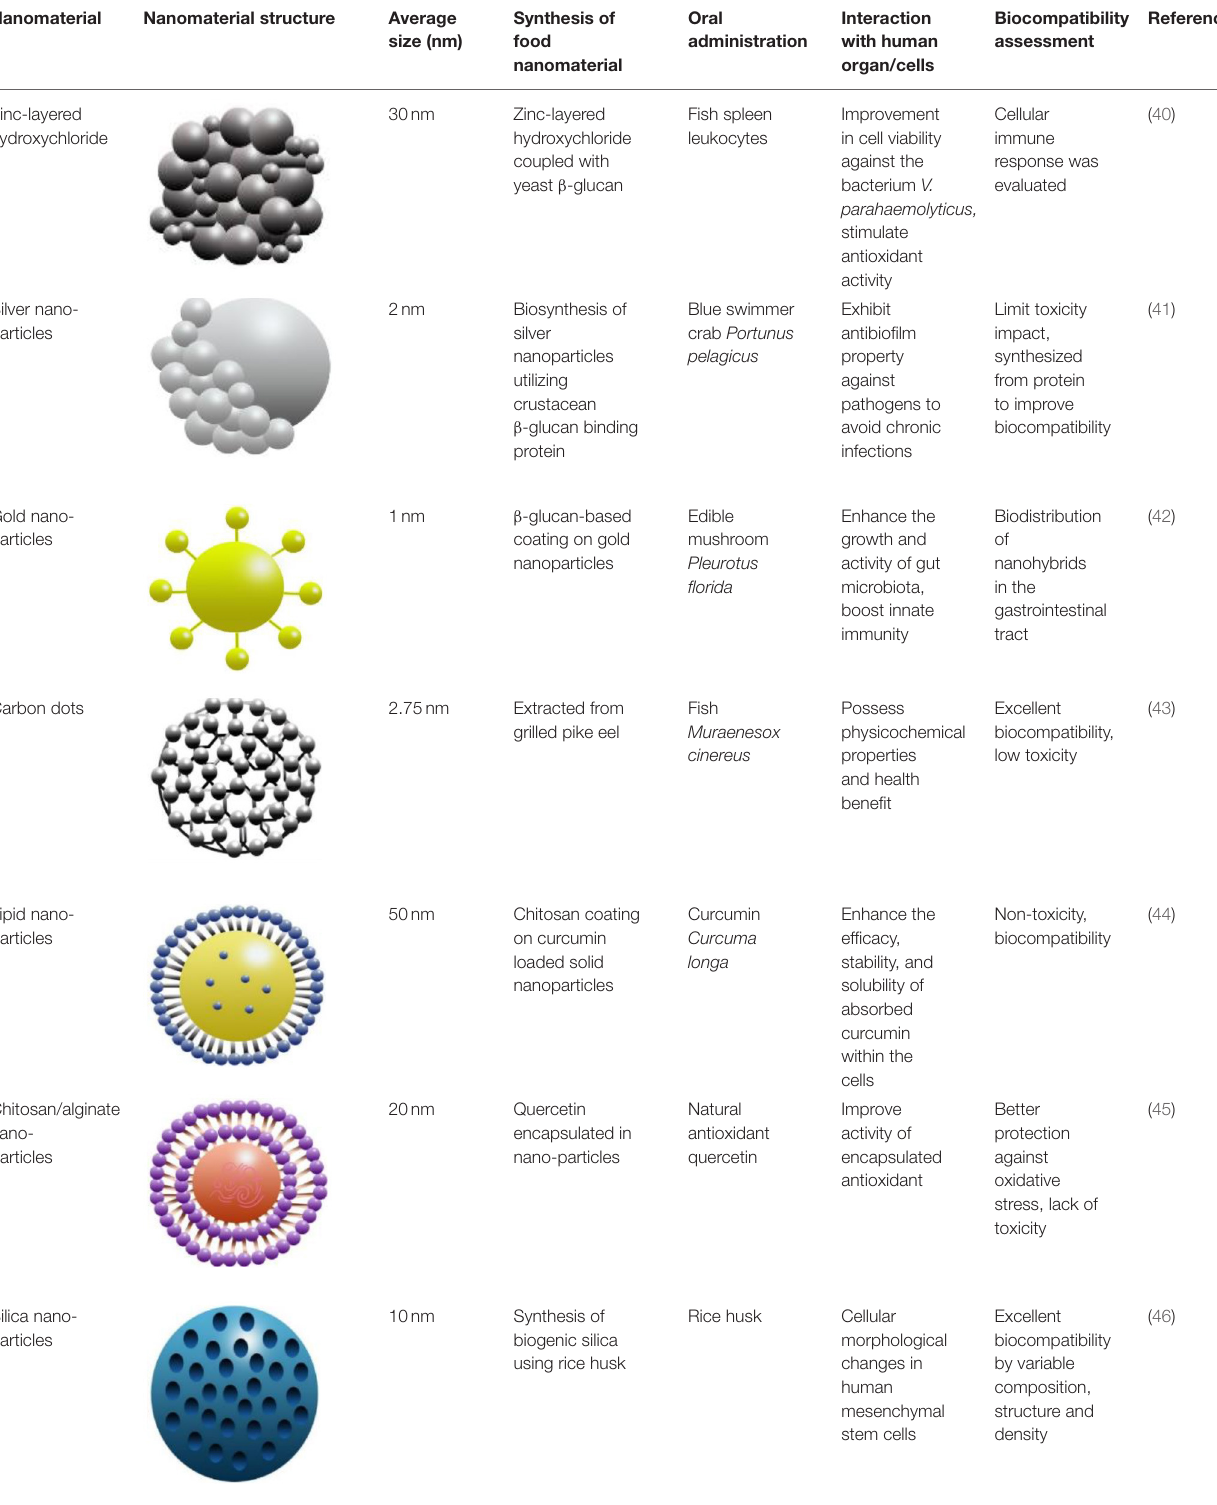
TABLE 1 | Biocompatibility of nanomaterials by consuming different nanofoods